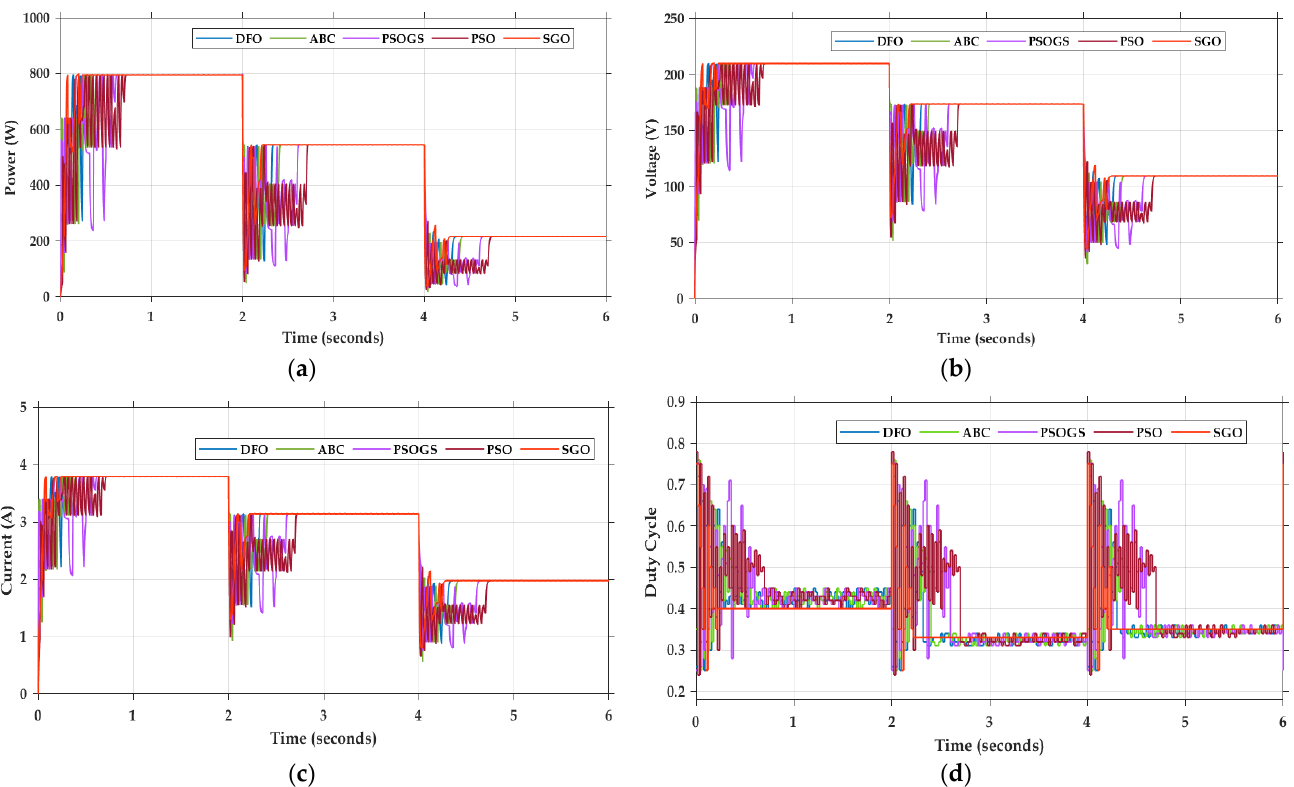
Figure 9. Case 1: comparison of ( a ) power, ( b ) voltage, ( c ) current, and ( d ) duty cycle of SGO, DFO, ABC, PSOGS, and PSO.